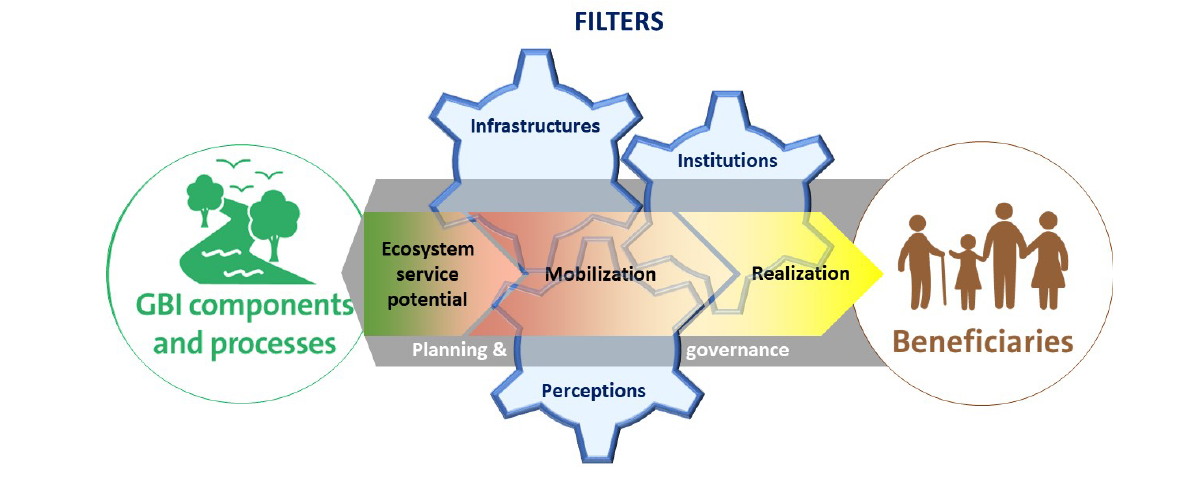
Fig. 1. Three systemic filters—infrastructures, institutions, and individual perceptions—shape the three steps (ecosystem service (ES) potential, mobilization, and realization) in the flow benefits from urban green and blue infrastructure (GBI) to beneficiaries, and hence, the final distribution of benefits. The filters represent core properties of the urban social-ecological-technological system (SETS), which means that people are connected to them through multiple linkages/relations and not just through the flow of ES benefits. People, beneficiaries, and society in general are actively interacting with and changing GBI, as well as the filters, and thus in turn, directly or indirectly, the flow and distribution of